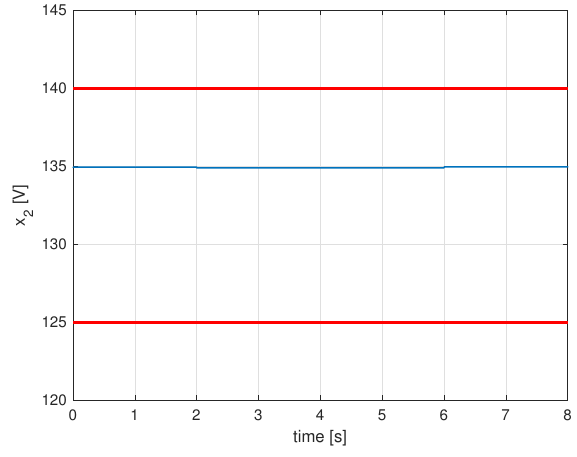
Figure 17. High voltage (HV) bus voltage (blue) and limits